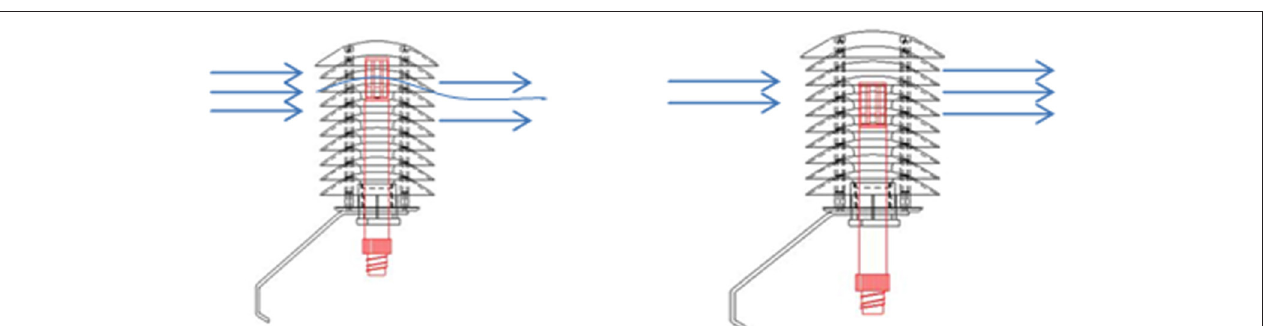
FIGURE 7 | Top view of the buoy with north alignment.